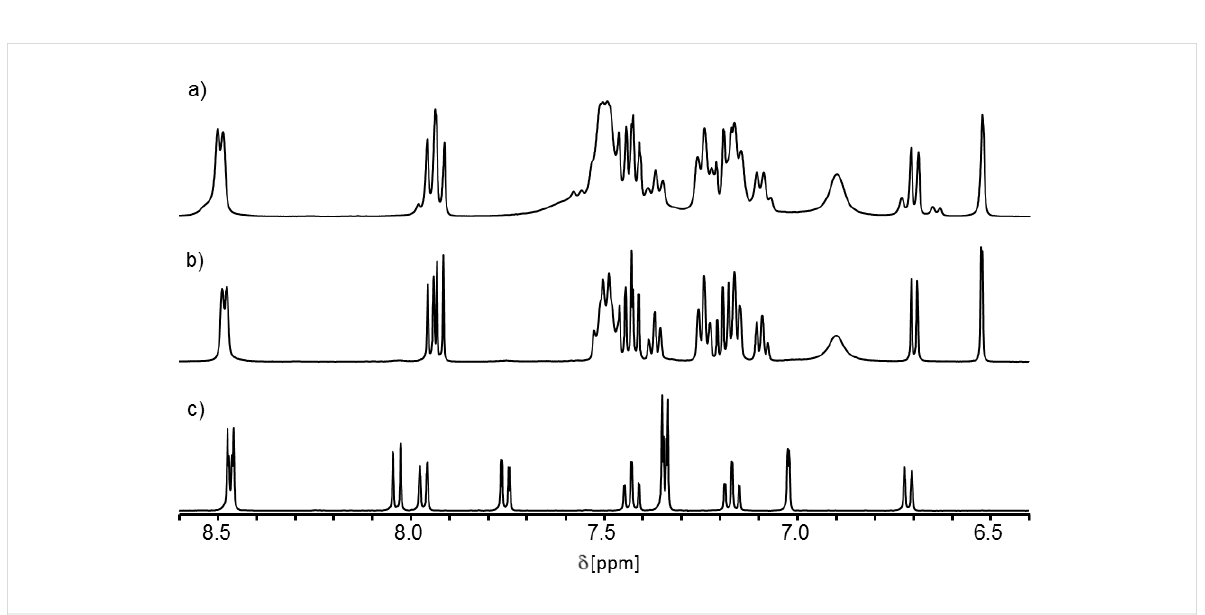
Figure 1: ESI mass spectrum (positive mode) of an 1:1 mixture of ( R )- 3 and [(dppp)Pd(OTf) 2 ] in acetone.